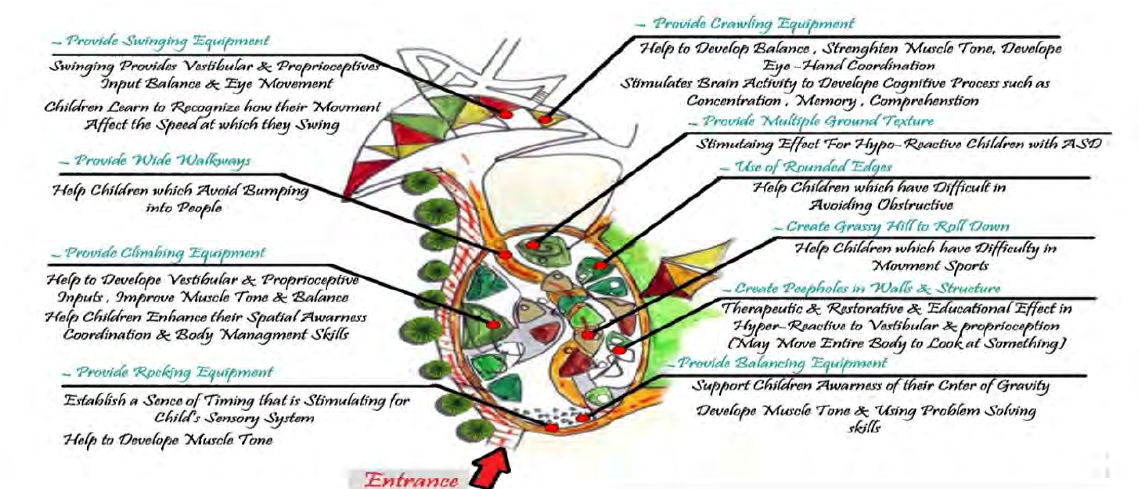
Figure 17. Shows the design consideration for the vestibular (balance) and proprioception (muscle and joint) zone